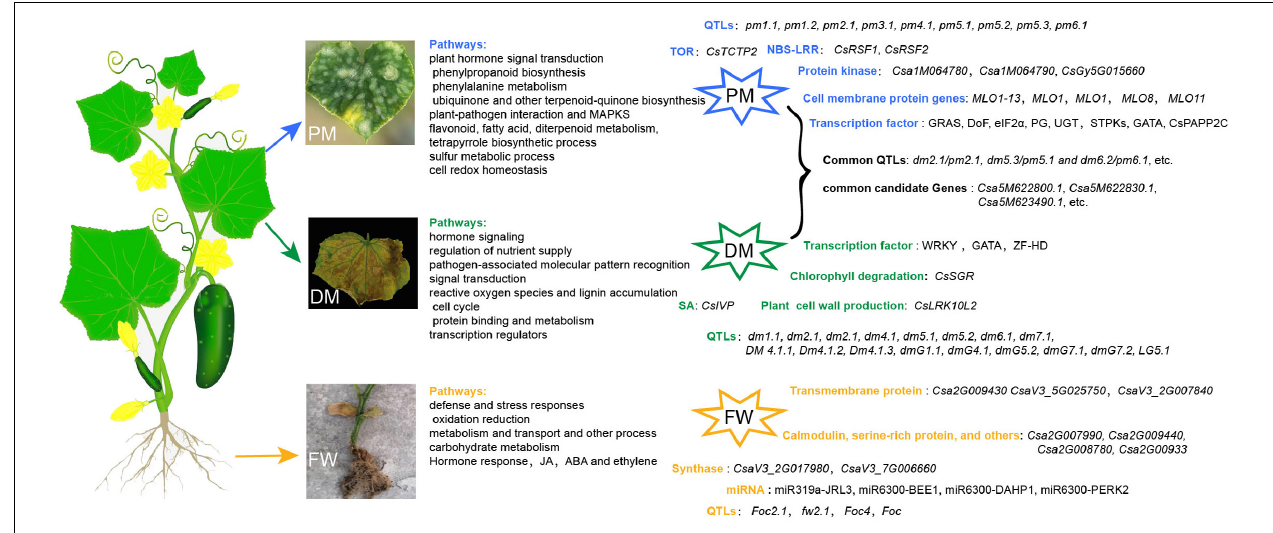
FIGURE 1 | The symptoms, QTL mapping and candidate genes or proteins related to cucumber PM, DM, and FW,